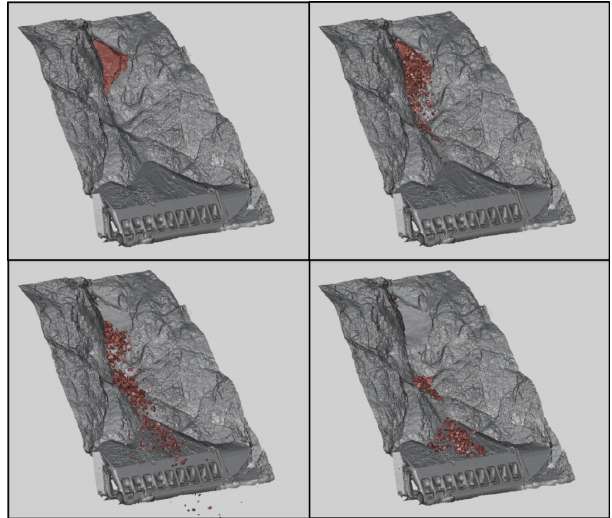
Figure 12. Screenshots of a fragmental rockfall simulation (1000 fragments) for the 170m 3 rockfall event at